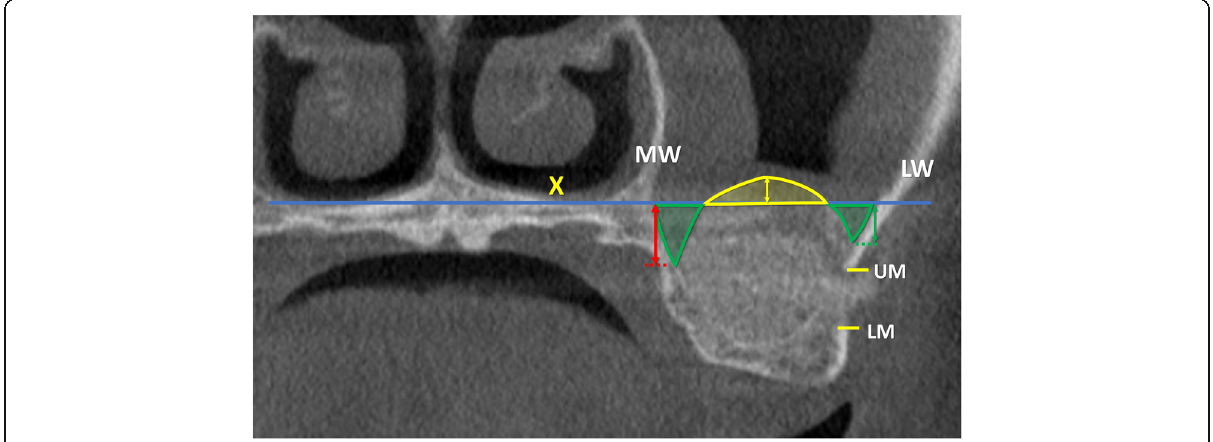
Fig. 3 T1, coronal view of a no-membrane CBCT; X, line drawn following the floor of the nose; F, base of the sinus floor; MW, medial wall of the sinus; LW, lateral wall of the sinus; UM, upper margin of the antrostomy; LM, lower margin of the antrostomy. Exceeding area (bordered in yellow), area above the line X filled with biomaterial/ bone tissue. Residual areas (bordered in green), the areas below the line X not filled with biomaterial/ bone tissue. Floor augmentation heights at the lateral (green arrow), middle (yellow arrow), and medial (red arrow)